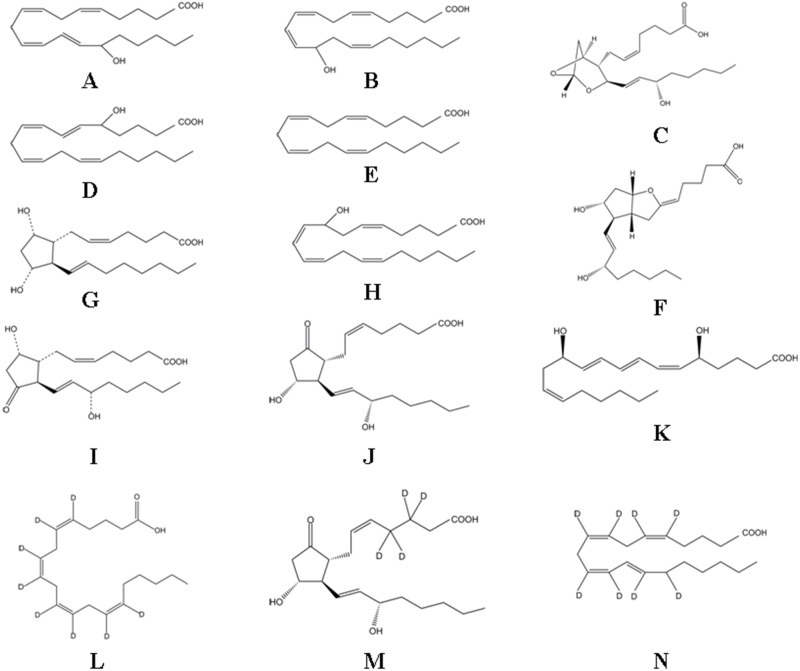
Chemical structures of AA and its metabolites.(A) 15-HETE, (B) 12-HETE, (C) TXA2, (D) 5-HETE, (E) AA, (F) PGI2, (G) PGF2α, (H) 8-HETE, (I) PGD2, (J) PGE2, (K) LTB4, (L) AA-d8, (M) PGE2-d4 and (N) 15-HETE-d8.